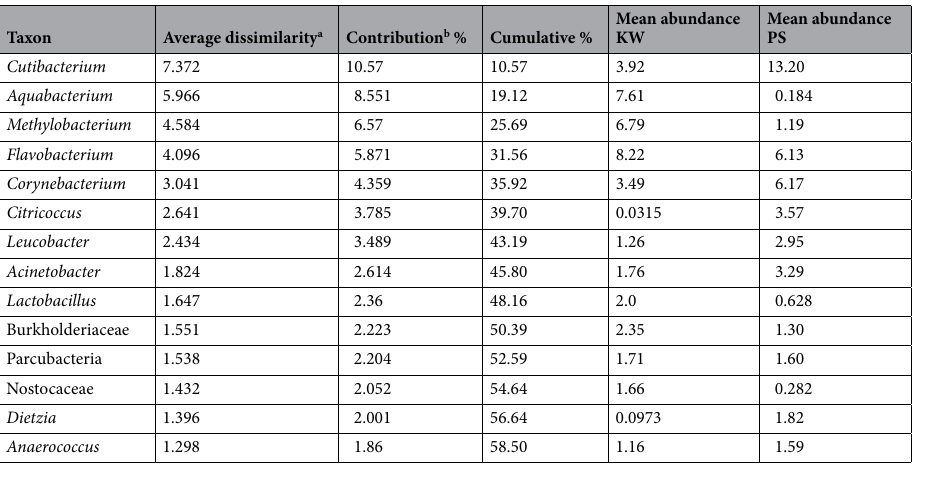
Table 1. SIMPER analysis results comparing PS and KW samples. The Bray–Curtis dissimilarity between PS and KS was greater than 1% for these 14 microbial genera. a Bray–Curtis average dissimilarity between PS and KS populations, expressed as a percentage. b Contribution to dissimilarity between PS and KS population. KW, parent population, PS, permethrin-selected